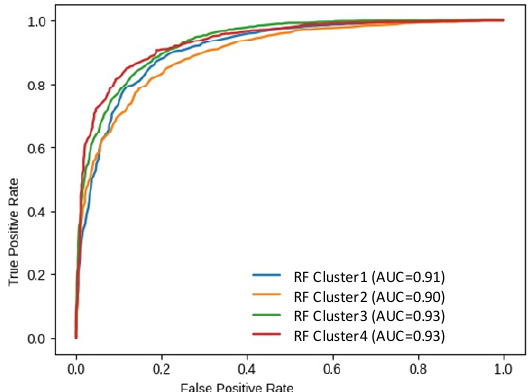
Figure 19. Random forest AUC variation in designed spatial clusters.